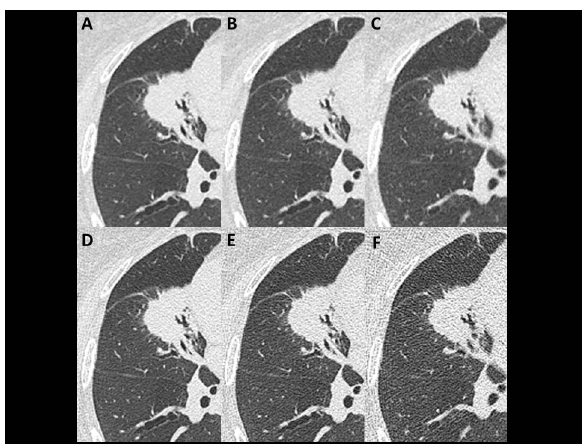
Figure 4. Axial plain chest CT images showing a ground-glass opacity (GGO) nodule in the left apex (74-year-old female weighing 49 kg). Images are arranged as in Figures 1 and 2. Nearly homogeneous density of the nodule was accurately depicted on images with AIDR3D at any of three tube currents ( A–C ). However, on images without AIDR3D ( D–F) , artificial density heterogeneity due to image noise increased as the tube current decreased from 240 ( D ) to 60 mA ( F ).